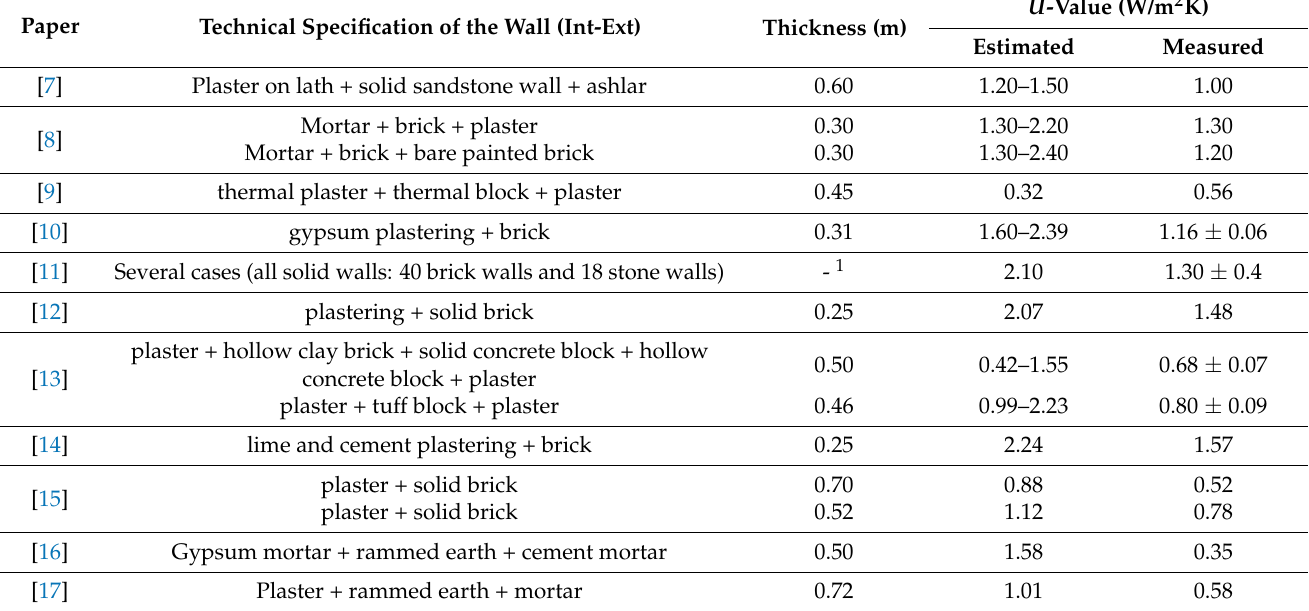
Table 1. Disparities found in literature review: estimated and measured U values in uninsulated and no air gap walls. Paper Technical Specification of the Wall